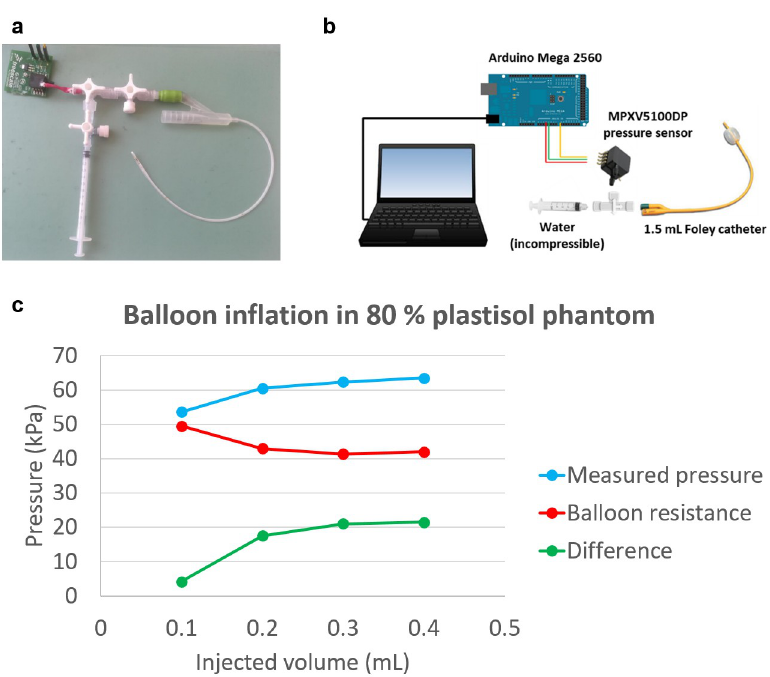
Fig 2. Details of the inflation experiment. (a) The Foley catheter used to mimic tumour expansion was connected to a MPXV500DP pressure sensor to measure the radial stress generated through inflation. (b) Schematics of the pressure data acquisition scheme. (c) The actual pressure exerted on the surrounding material is obtained through the subtraction of the intrinsic balloon resistance from the measured pressure.